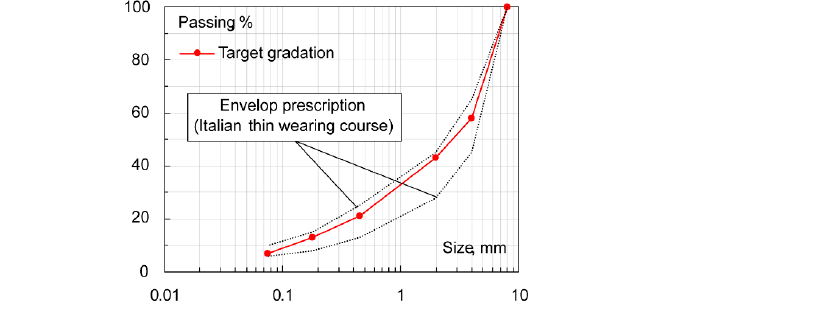
Figure 3. Envelop specifications and target gradation of ACL and ACS mixes.